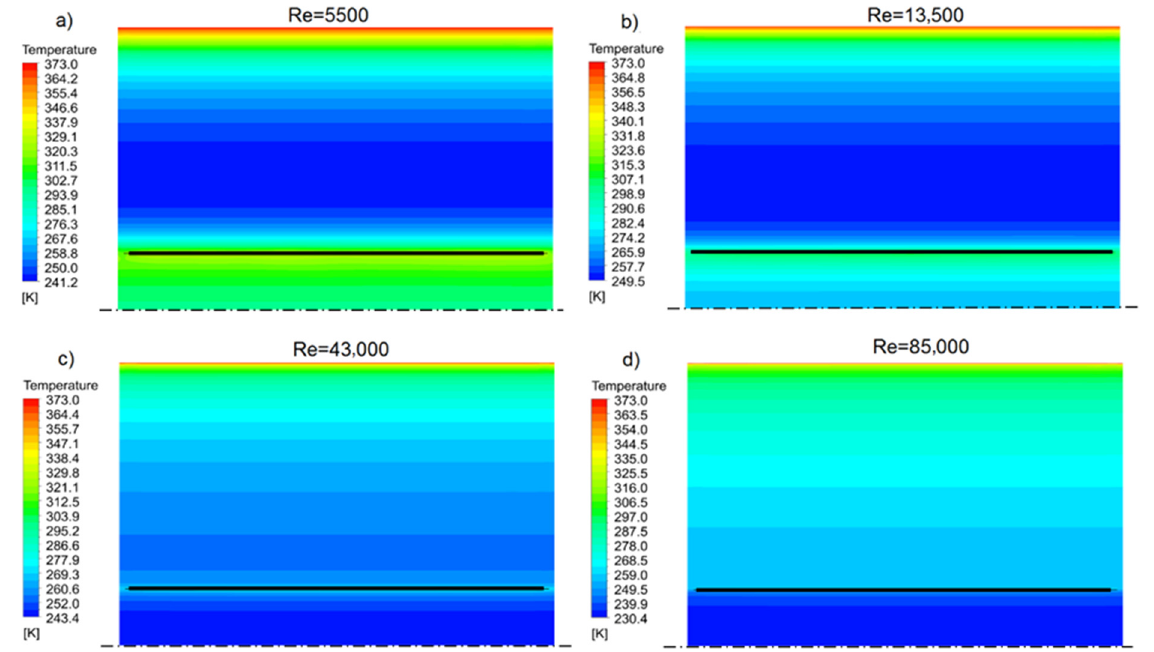
Figure 9. Temperature profiles in the symmetry plane for a dimensionless insert diameter D = 0.2 and several Re numbers: ( a ) Re = 5500, ( b ) Re = 13,500, ( c ) Re = 43,000 and ( d ) Re = 85,000.